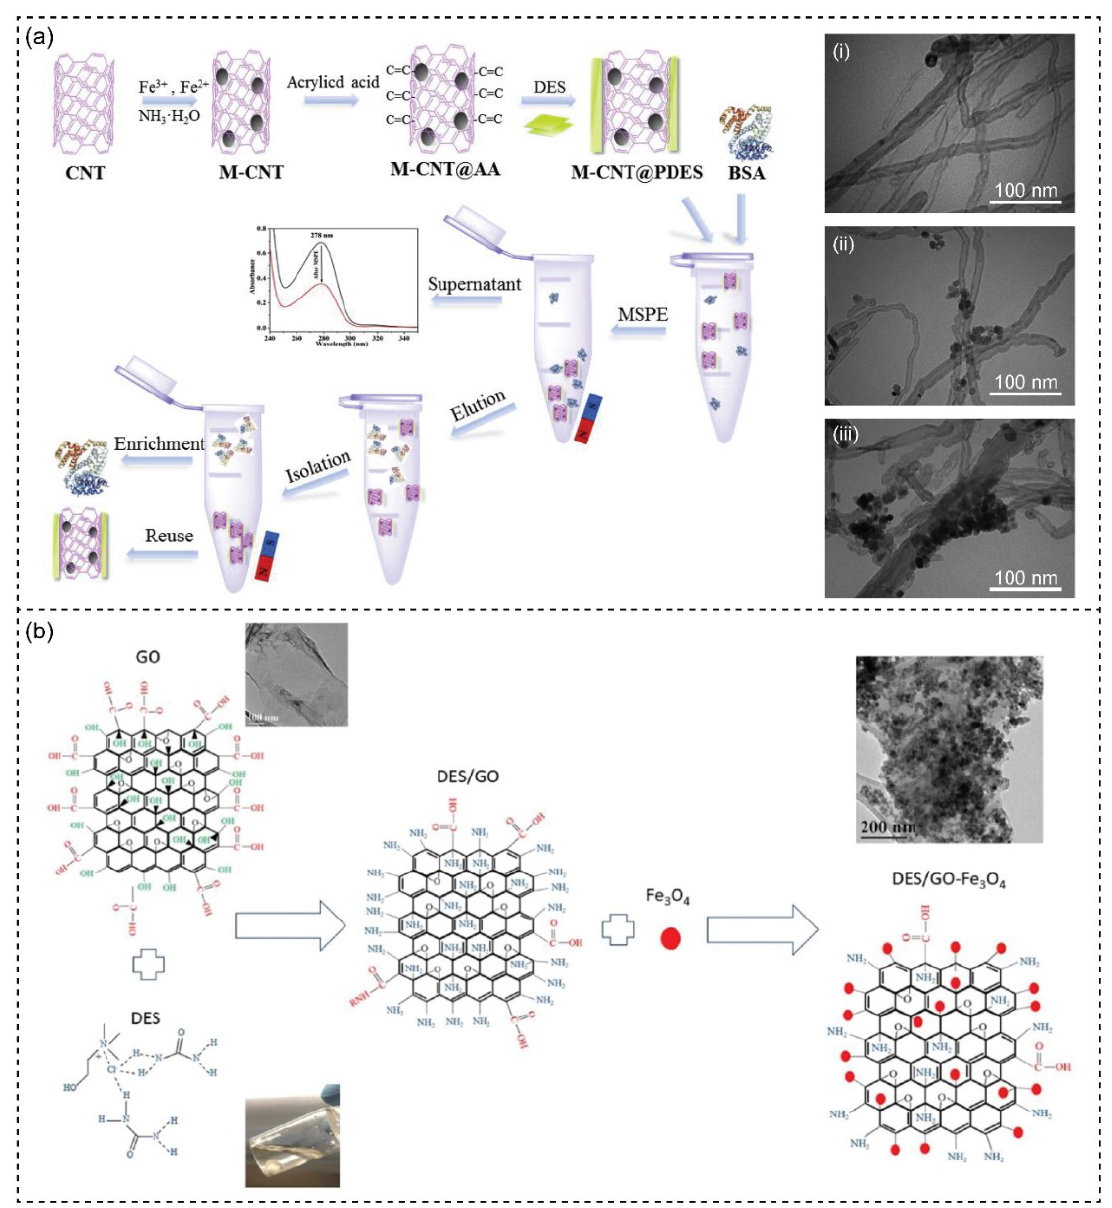
Figure 7. ( a ) Schematic illustration of the fabrication process of magnetic carbon nanotubes modified with polymeric DES (M-CNT@PDES) and its design application for extraction of bovine serum albumin (BSA). TEM images of CNT (i), M-CNT (ii), and M-CNT@PDES (iii). Reprinted with permission from ref. [194]. Copyright 2020 Elsevier. ( b ) Schematic illustration of the conjugation of magnetic nanoparticles (MNPs) onto graphene oxide (GO) using ChCl-U and its application for lead(II) and methylene blue removal. Inset TEM image of bare GO nanosheets and DES functionalized GO nanosheets (DES@GO). Reprinted with permission from ref. [199]. Copyright 2020 Elsevier.